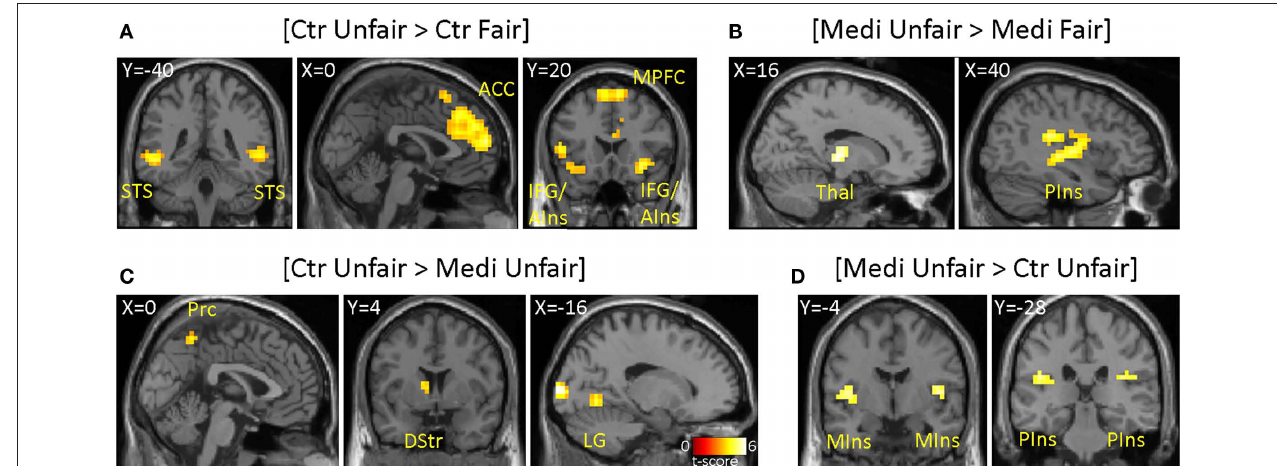
(PIns), left mid-anterior insula, and ACC. Direct comparison between unfair offers across groups: (C) Left precuneus (Prc), left dorsal striatum (DStr), and lingual-occipital gyri (LG) are shown overlaid on coronal and sagittal sections. (D) Bilateral mid insula (MIns) and bilateral posterior insula (PIns) are shown on separate coronal sections. The activations are FDR-corrected. The ACC is displayed at p < 0.001, uncorrected to illustrate the extent of the